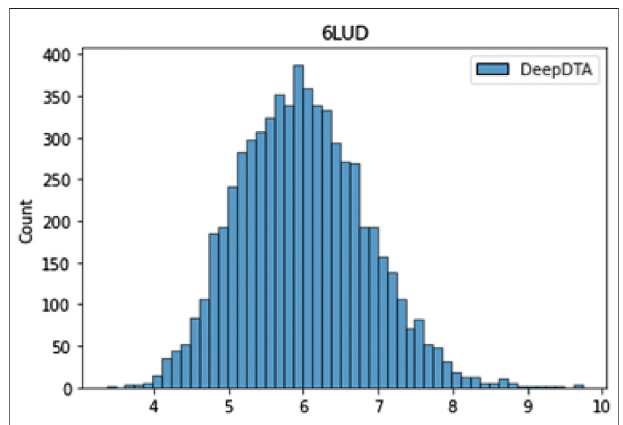
FIGURE5| Drugtargetaf fi